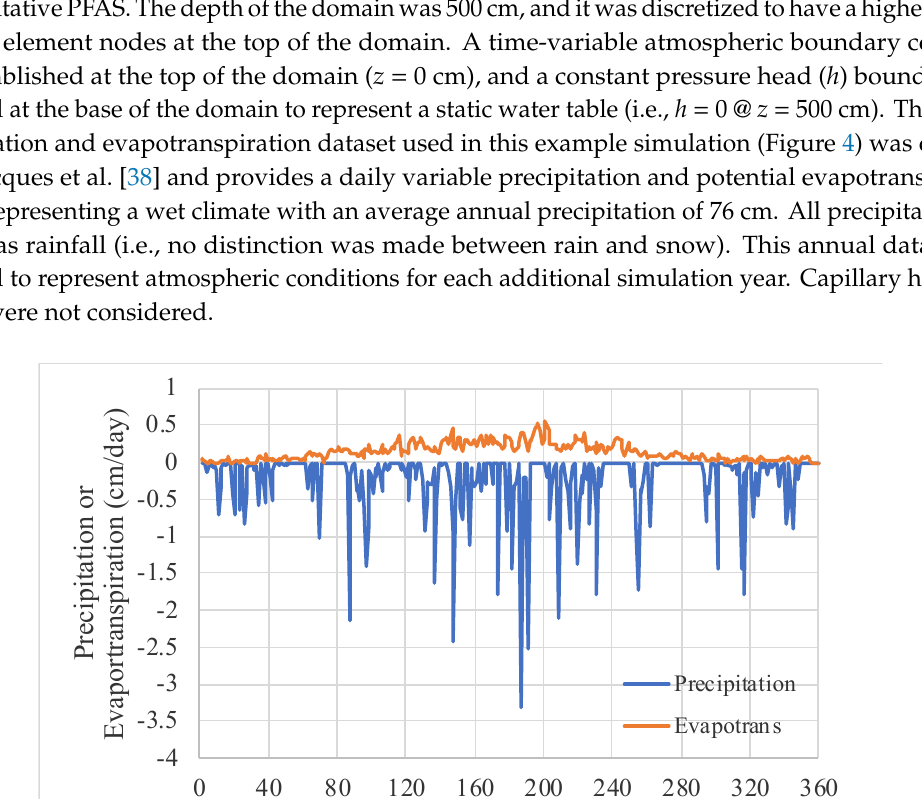
Table 3. Additional Model Parameters.